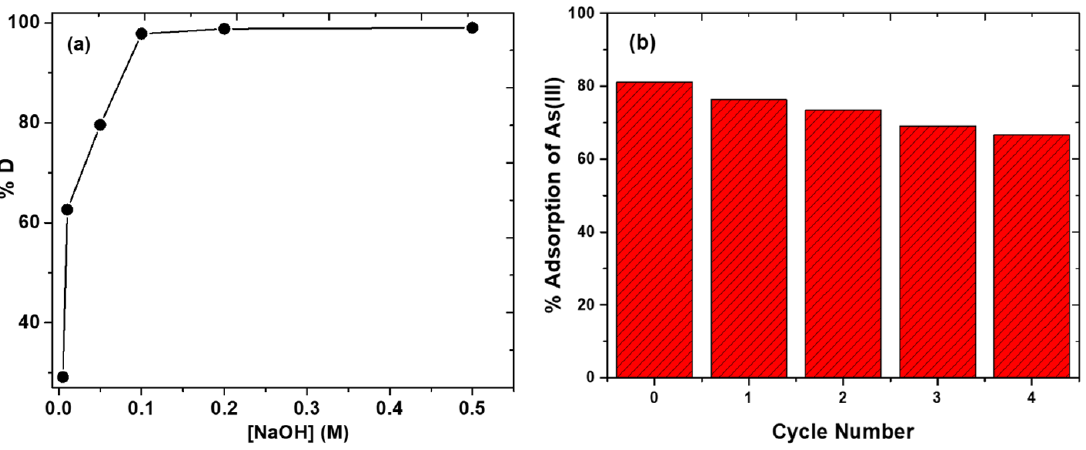
Figure 8. ( a ) Desorption of arsenic from arsenic loaded PP@TiO 2 . (Conditions: weight of loaded PP@TiO 2 = 25mg, volume of eluent = 25mL, V/m = 1000mL/g, adsorbed amount of arsenic = 20.34 mg/L, T = 25 °C, contact time = 24 h); ( b ) variation of the adsorption capacity of the PP@TiO 2 in subsequent adsorption-desorption cycles of As(III).